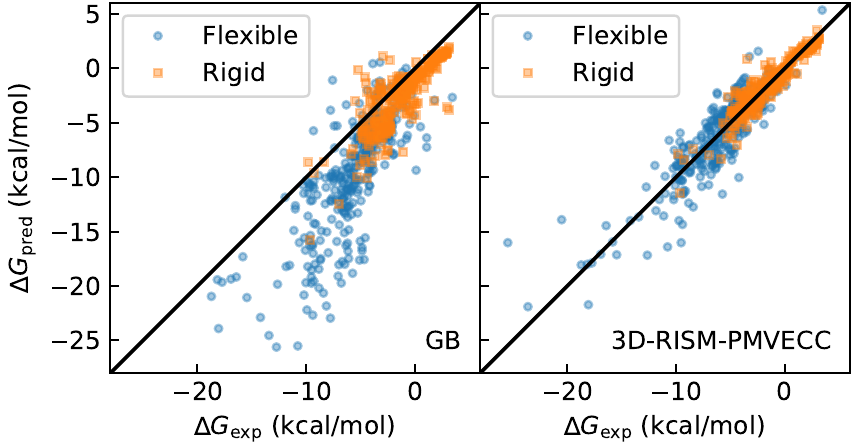
Figure 3. HFEs from single (original conformation) rigid and flexible datasets for GB and 3D-RISM with